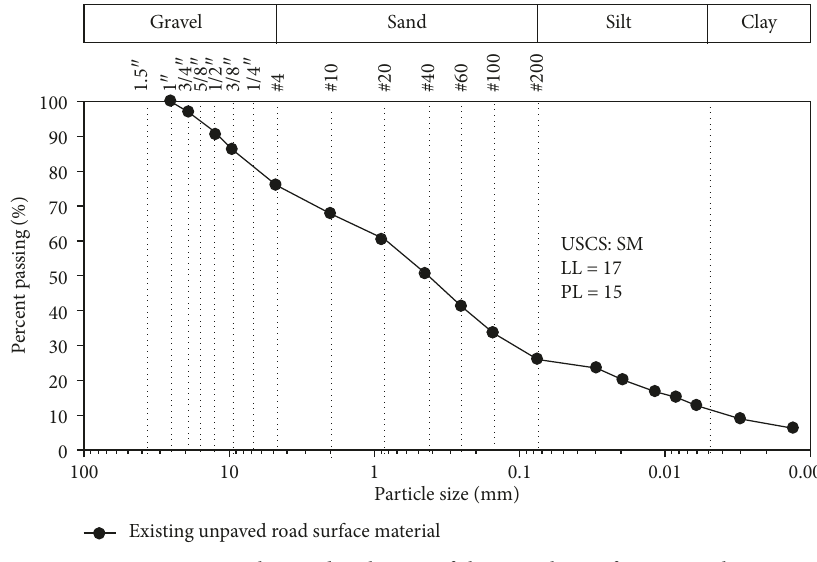
Figure 2: Particle size distribution of the granular-surface material. Table 2: Chemical composition of the bentonite used in the lab